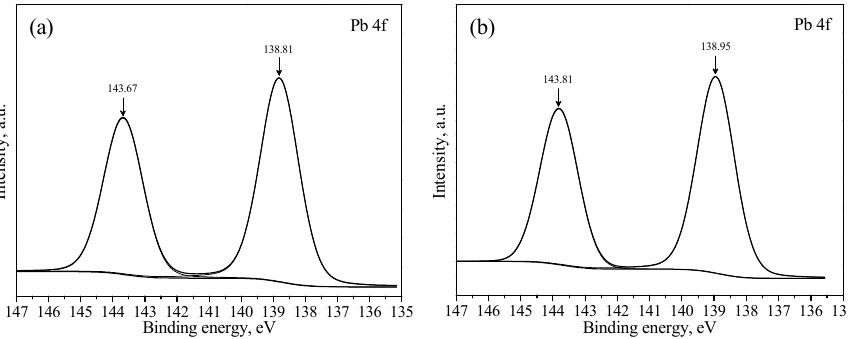
Figure 5. Pb 4f spectra for the mineral surface treated with chloride ions: ( a ) before; ( b ) after.